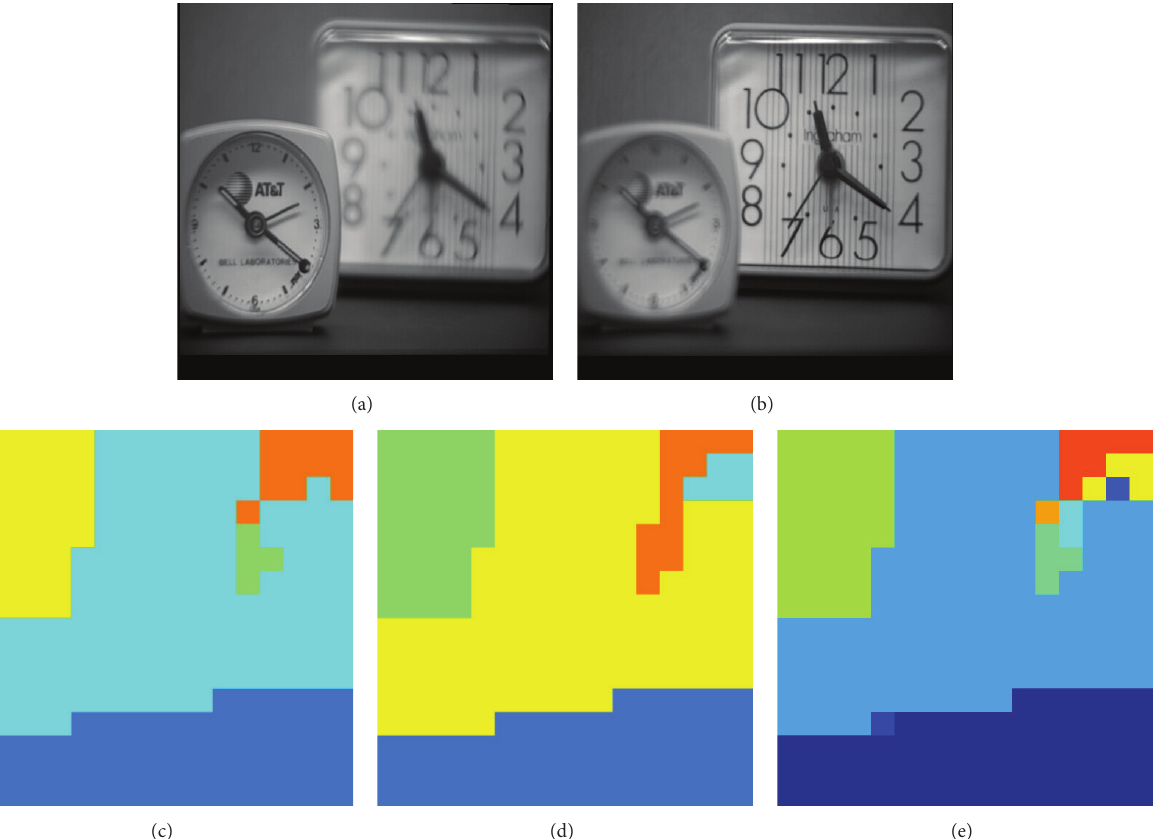
Figure 2: (a) Left-focus clock, (b) right-focus clock, (c) regional partition of left-focus clock, (d) regional partition of right-focus clock, and (e) joint partition of two